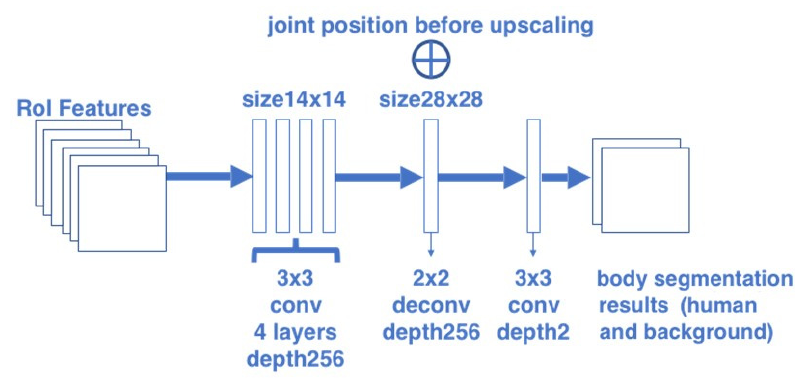
Figure 9. Joint position estimation branch combined with body segmentation (for Figure 8a).